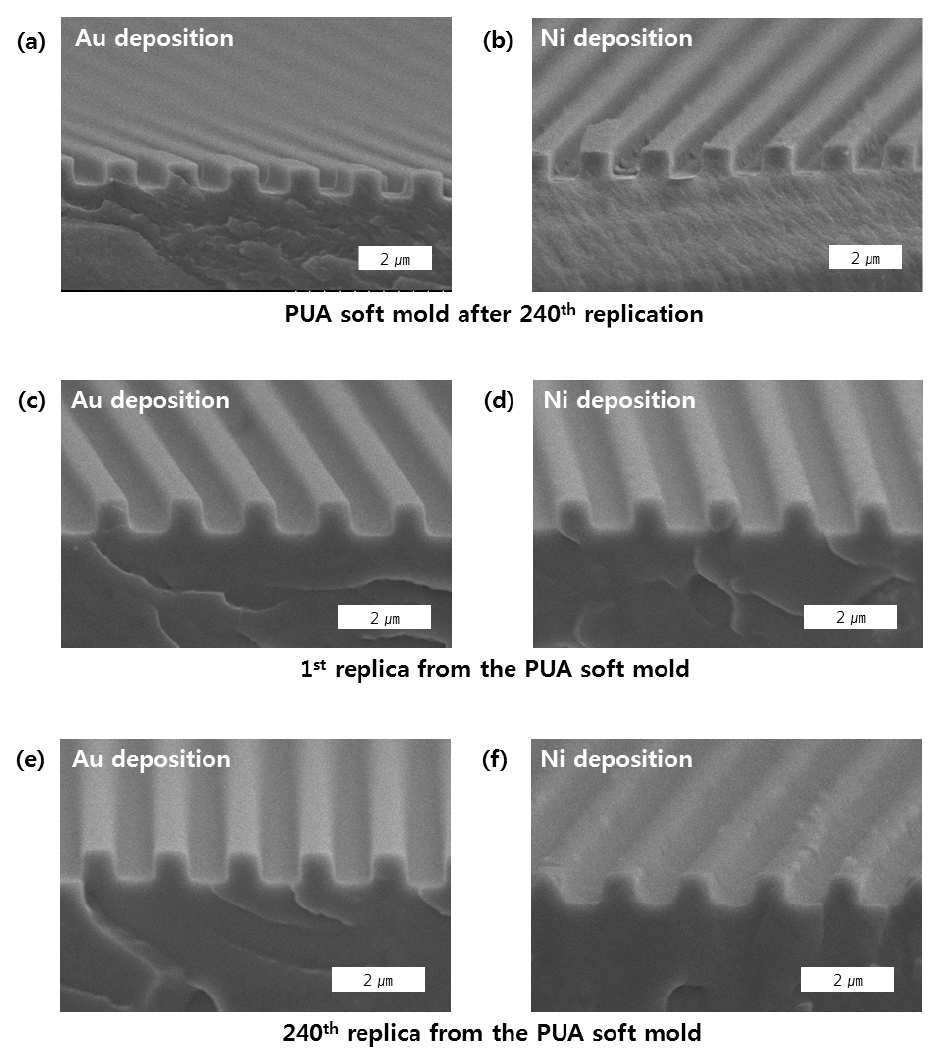
Figure 5. SEM images of metal deposition PUA soft mold and its replica after imprinting process. ( a , b ) PUA soft mold after 240th replication. ( c , d ) 1st replica. ( e , f ) 240th replica. (Left: Au deposition, Right: Ni deposition).